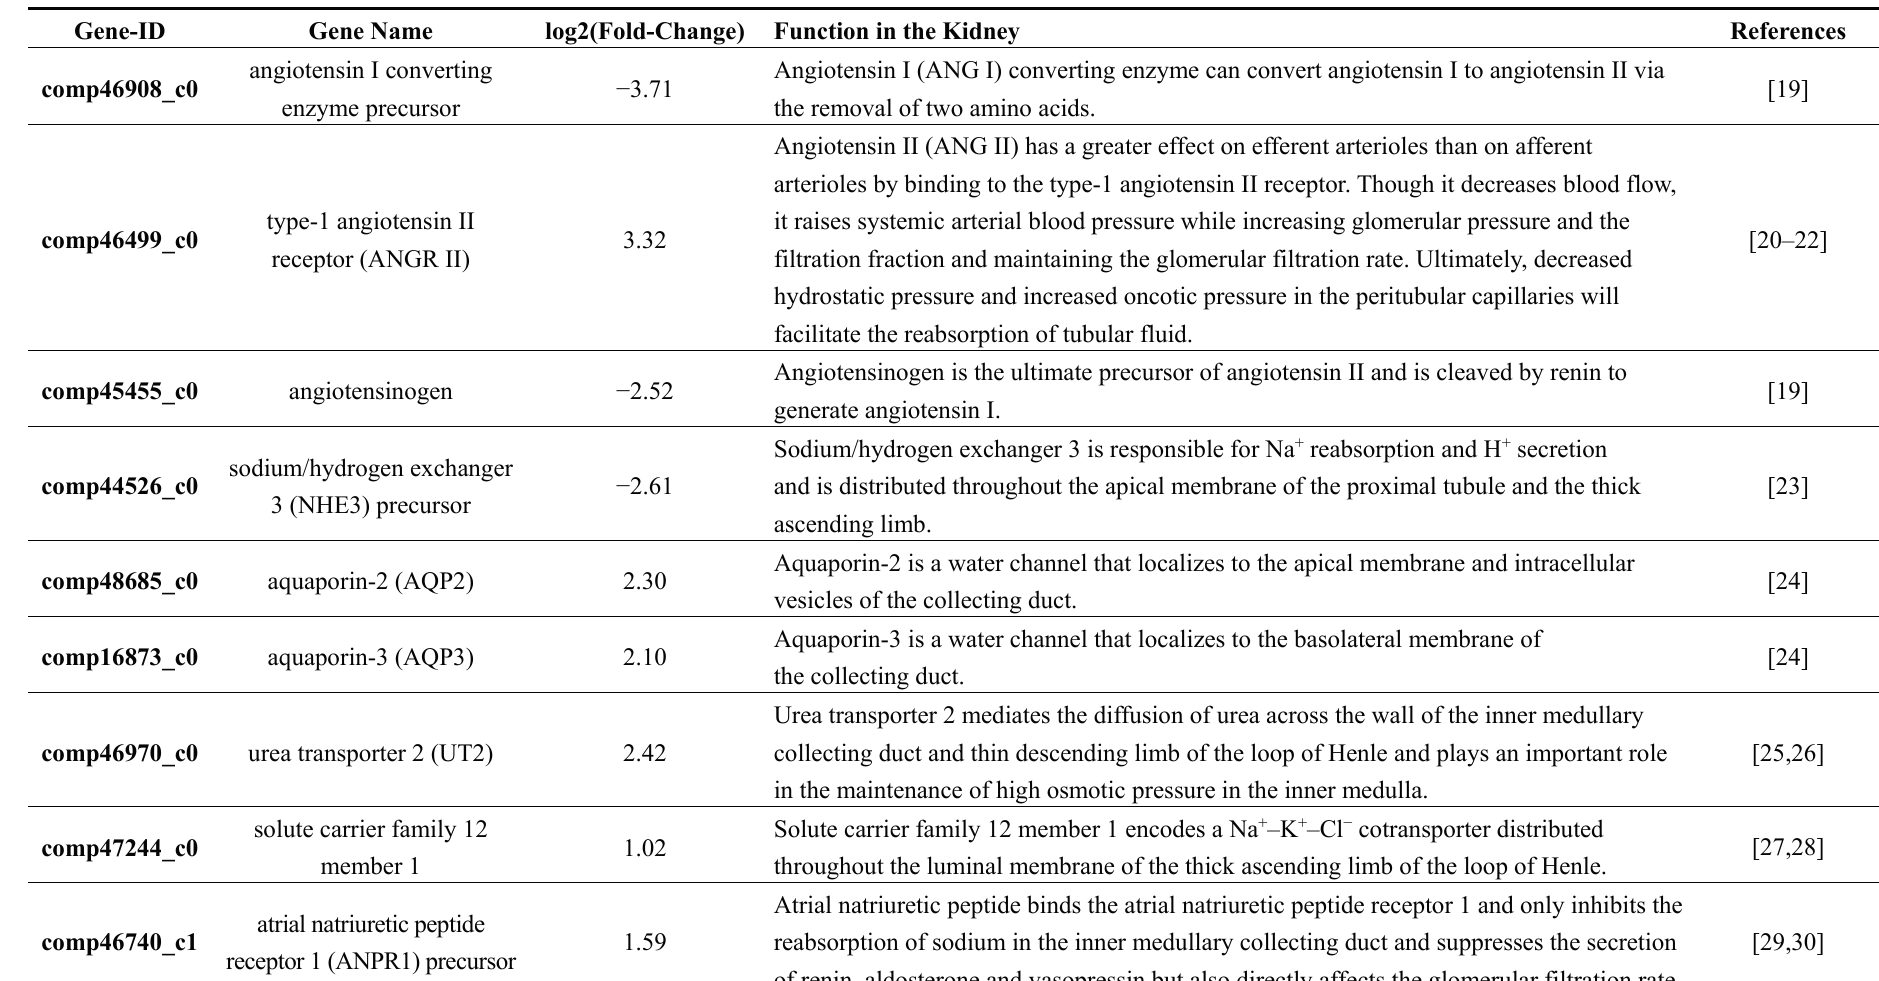
Table 4. DEGs related to urine formation were selected from the GO term integral to membrane and the KEGG pathway of the renin-angiotensin system. DEGs: differentially expressed genes; GO: Gene Ontology; KEGG: Kyoto Encyclopedia of Genes and